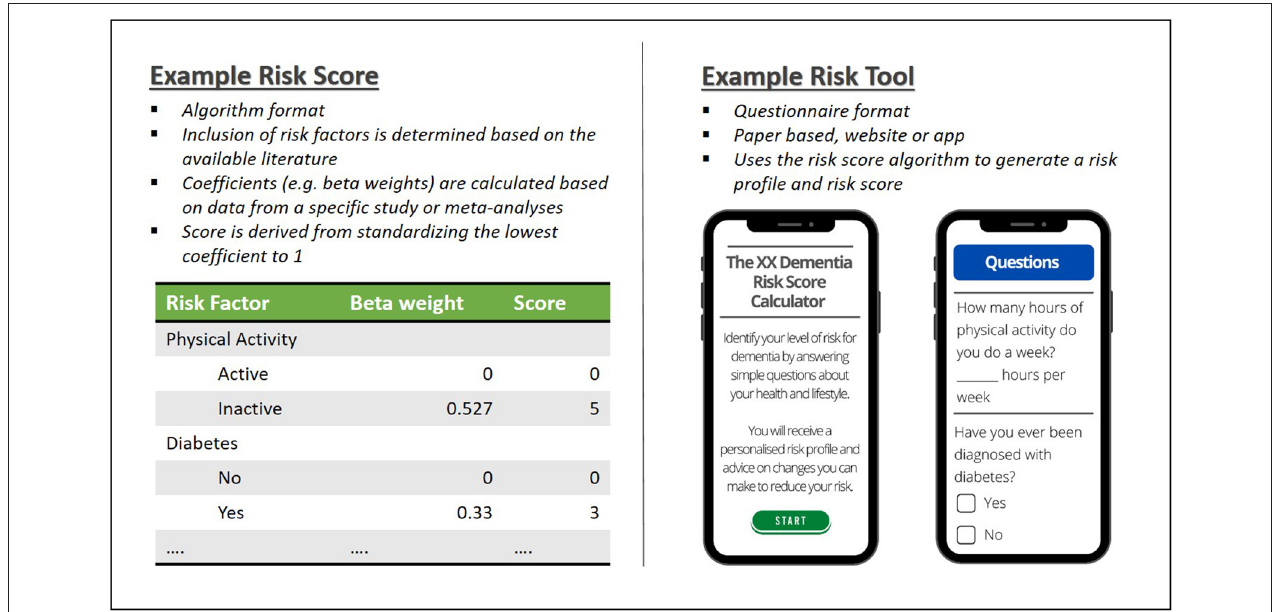
FIGURE 1 | Risk score and risk tool examples. Risk Reduction for Cognitive Decline and Dementia focused on interventions that reduce or reverse risk factors